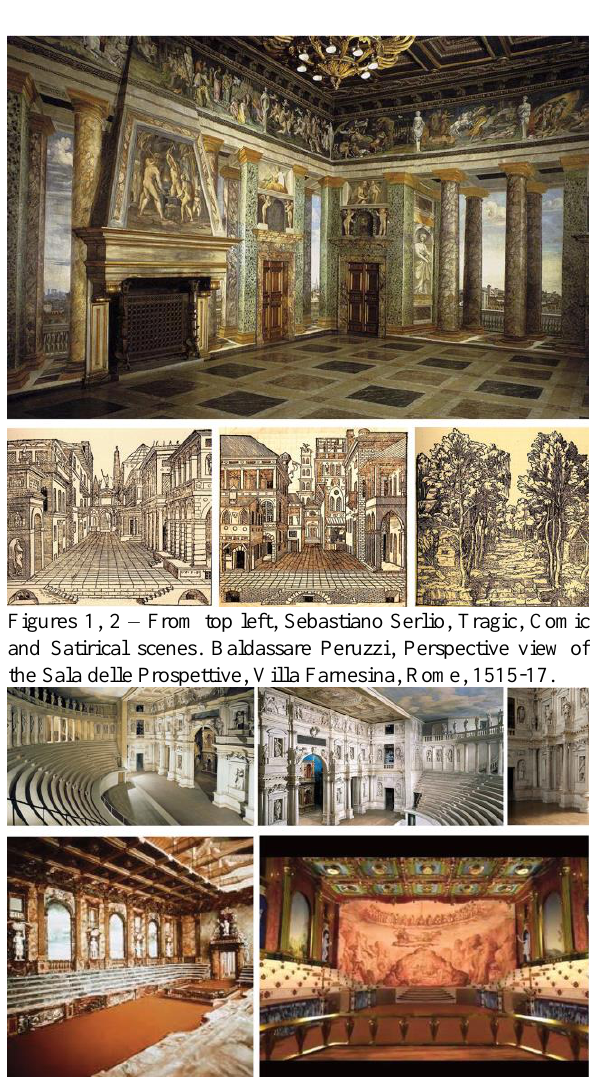
Figure 3 - From top left, Andrea Palladio. Olympic theater of